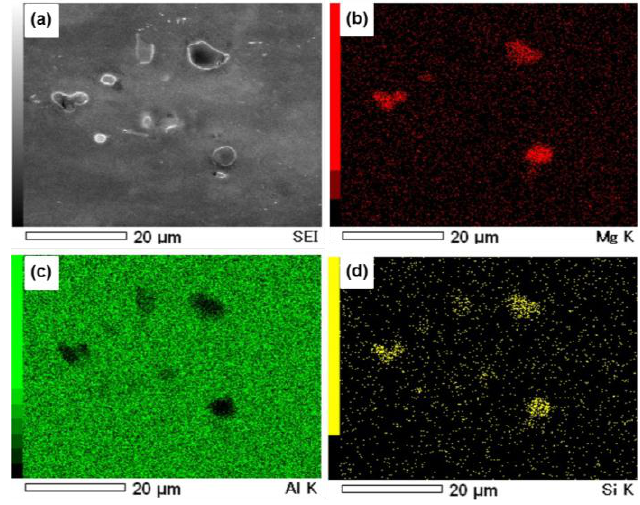
Figure 7. The EDS mapping showing the Mg 2 Si particles distributed in the area of the 6061 Al alloy. ( a ) SEM image and corresponding distribution of ( b ) Mg; ( c ) Al; and ( d ) Si elements